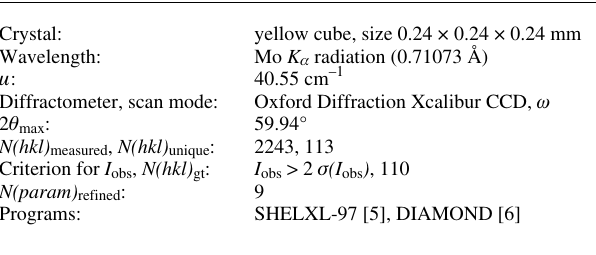
Table 1. Data collection and handling. Table 2. Atomic coordinates and displacement parameters (in Å 2 )